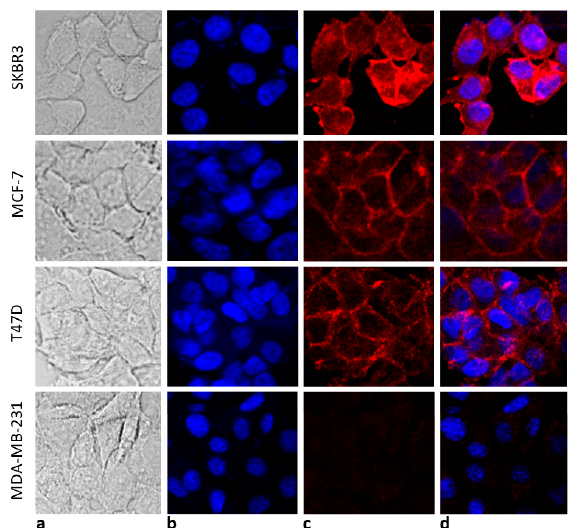
Figure 1. Images of immunofluorescence by confocal laser scanning microscopy (CLSM) of four different breast cancer cell lines: MCF-7, SKBR3, T47D and MDA-MB-231 ( a ) bright field; ( b ) staining of the cell nucleus by the fluorophore DAPI (blue); ( c ) indirect detection of HER2 by a primary anti-HER2 antibody and an anti-anti-HER2 secondary antibody bound to Alexa Fluor 594 fluorophore (red) and ( d ) cell localization of HER2 receptor by overlapping of images (DAPI + HER2). Magnification: 63×.